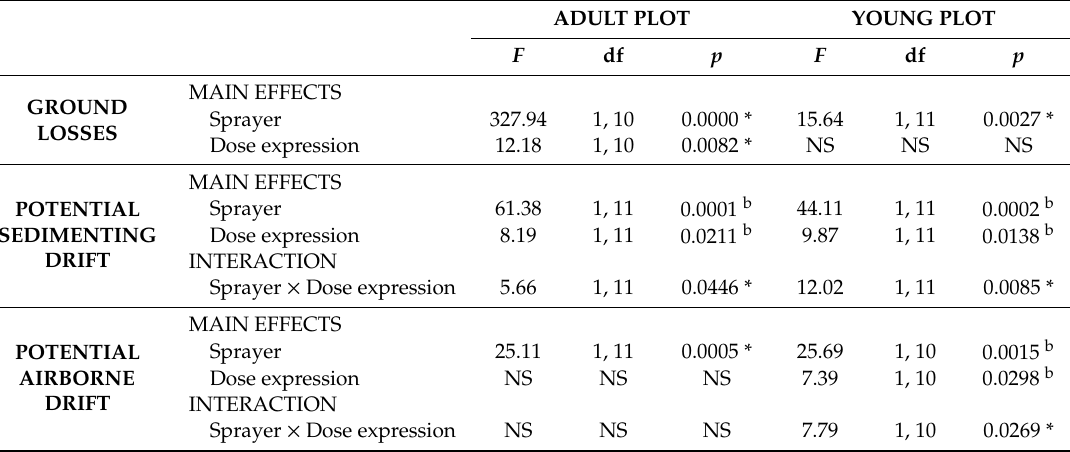
Table 9. Multifactor ANOVA results for the off-target losses ( μ L cm − 2 ) in the adult and young plots (LSD test, p < 0.05) a .